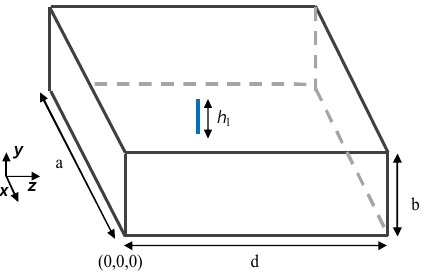
Figure 8. The enclosure excited by a monopole a=28cm, b=3.8 cm, d=42cm, h1=1 cm Q=1000